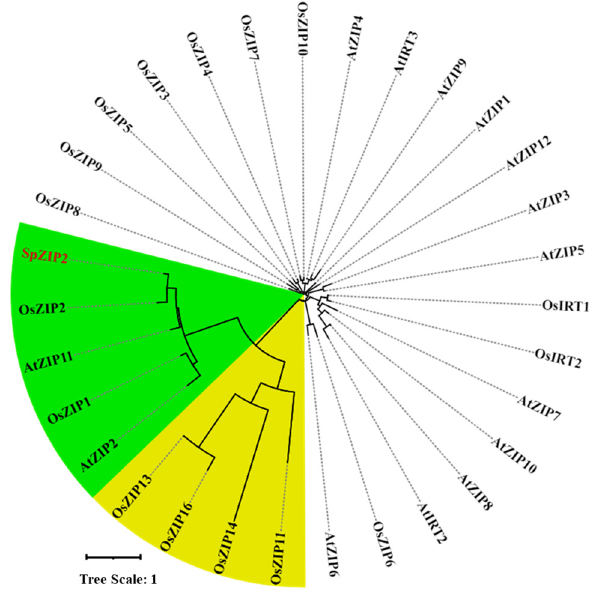
Figure 3. Phylogenetic analysis for SpZIP2 and ZIP members from rice and Arabidopsis thaliana ( A. thaliana ). SpZIP2 is shown in red color and its closely related ZIP members are shown by a green background.